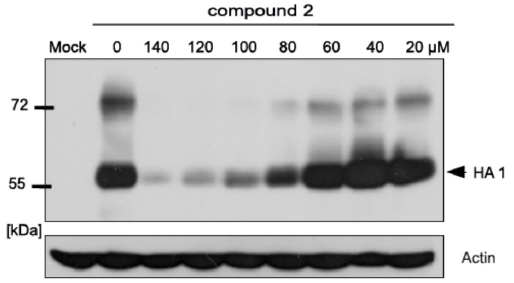
Figure 5. Effect of compound 2 on influenza A virus HA glycoprotein synthesis. Madin-Darby canine kidney cells (MDCK) cells were infected with influenza A virus (pandemic human A/H1N1 virus) and treated with various concentrations of compound 2 . At 48 h post-infection, cells were lysed, and proteins were separated by SDS–PAGE (10% polyacrylamide) under reducing conditions. Western blot analysis was performed using the specific rabbit polyclonal serum anti-sHA and anti- β -actin monoclonal antibodies. HA: Hemagglutinin.